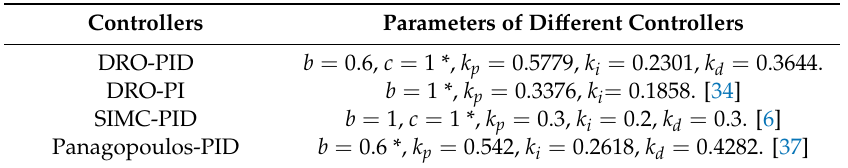
Table 5. Parameters of di ff erent controllers for Example 2.